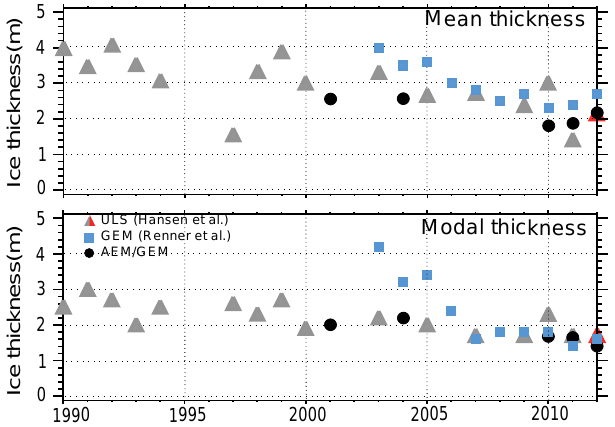
Figure 5. Comparison of mean (upper panel) and modal (lower panel) EM ice thicknesses (ice plus snow thickness) as obtained by ULS (source: Hansen et al., 2013), GEM (source: Renner et al., 2014) and GEM/AEM measurements in Fram Strait area. Gray/red triangles represent average August/July ULS measure- ments. The blue rectangles correspond to GEM measurements car- ried out between end of August and September. Black dots repre- sent AEM/GEM measurements obtained during two cruises with RV Polarstern (August 2001 and 2004) and three surveys with the research aircraft Polar 5 (August 2010 and 2011, July 2012).